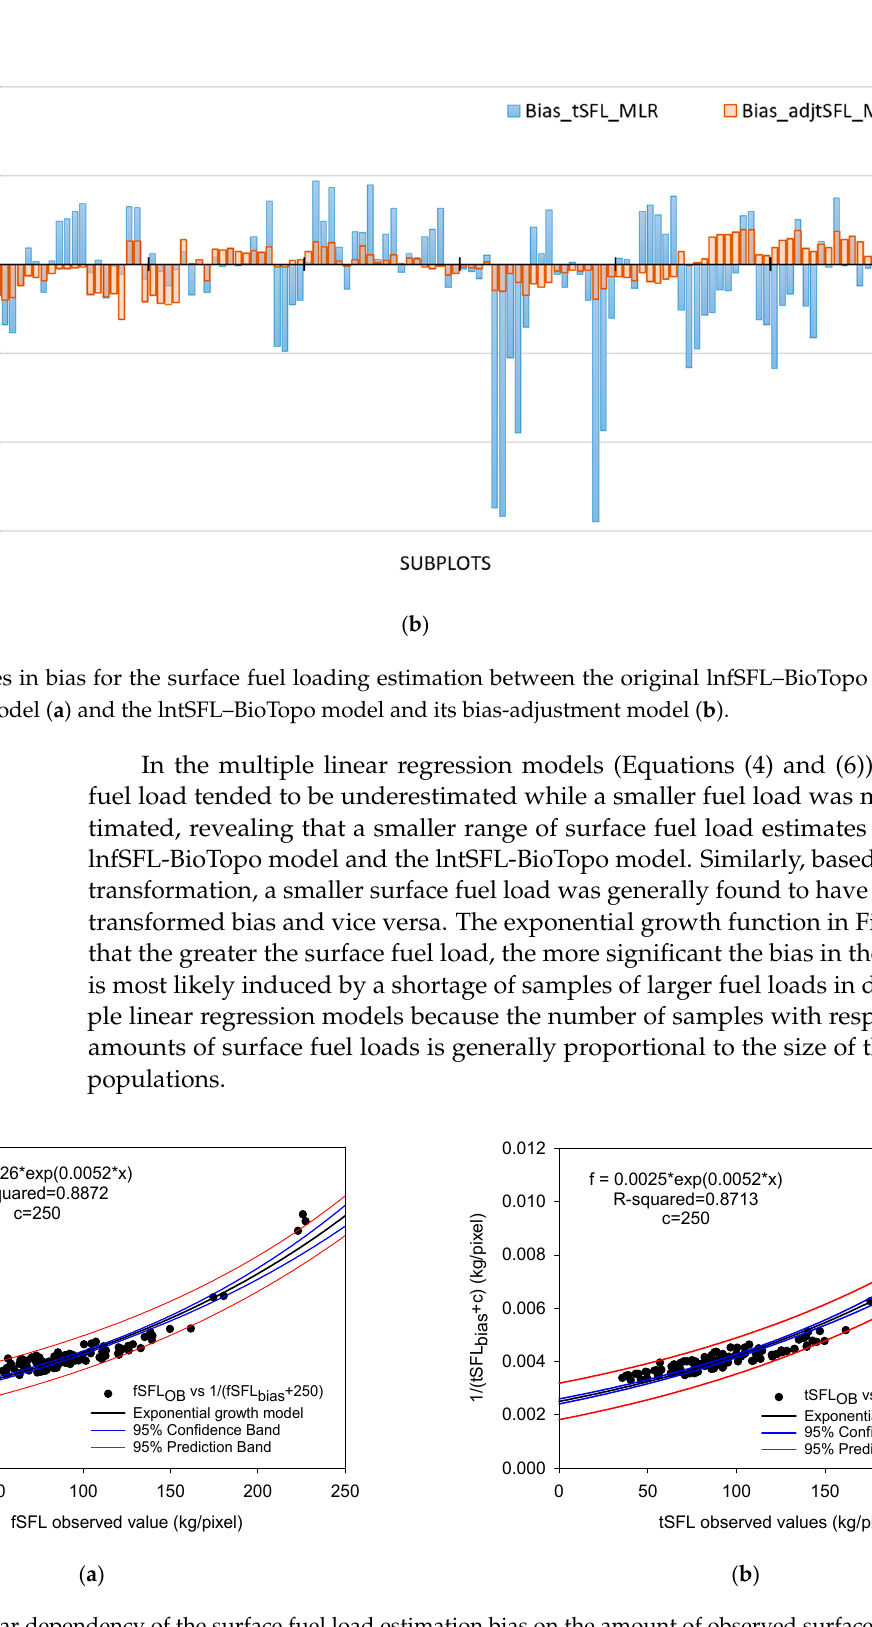
( b ) Figure 12. Probability density function of the observed values of surface fuel mass. The distribution of inventory fuel mass data is GL(tSFL; 0.1804, 18.57, 90.04) ( a ) and GL(fSFL; 0.2109, 17.38, 84.35) ( b ) where the x -axis is the observed value of fuel loads and the y -axis is the percentage frequency of individual fuel loads. 4.4. An Examination of the Appropriateness of the Cokriging-Based Surface Fuel Mapping Method An additional independent inventory of surface fuel loads was carried out in an area of 10 × 10 square meters for examining the appropriateness of the sampling scheme in deriving the plot-based SFL map. The SFL of the whole plot was 100collected. As shown in Table 6, a few samples of 2-m size microplots located in the black cells of the locational